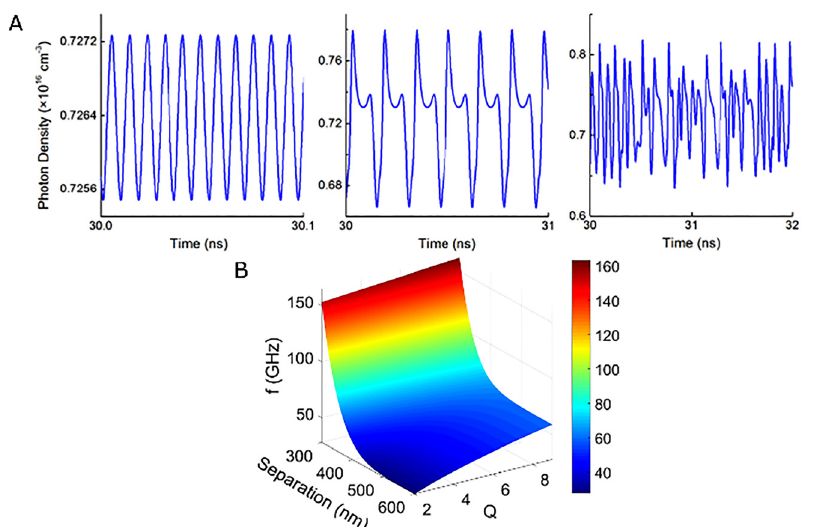
Figure 2: Periodic intensity oscillations. (A)Numericalsimulationsofphotondensity of one laser in a system of two mutually coupled nanolasers. Unstable dynamics such as periodic output (left),